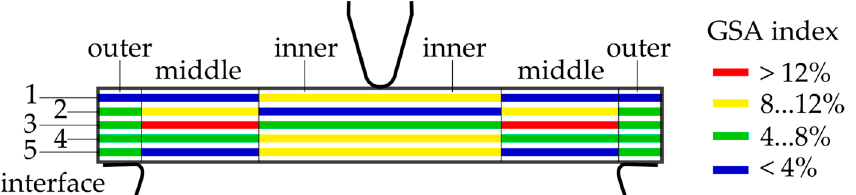
Figure 11. Influence of the sectional interface modification on the structural behaviour of the three- point-bended beam.